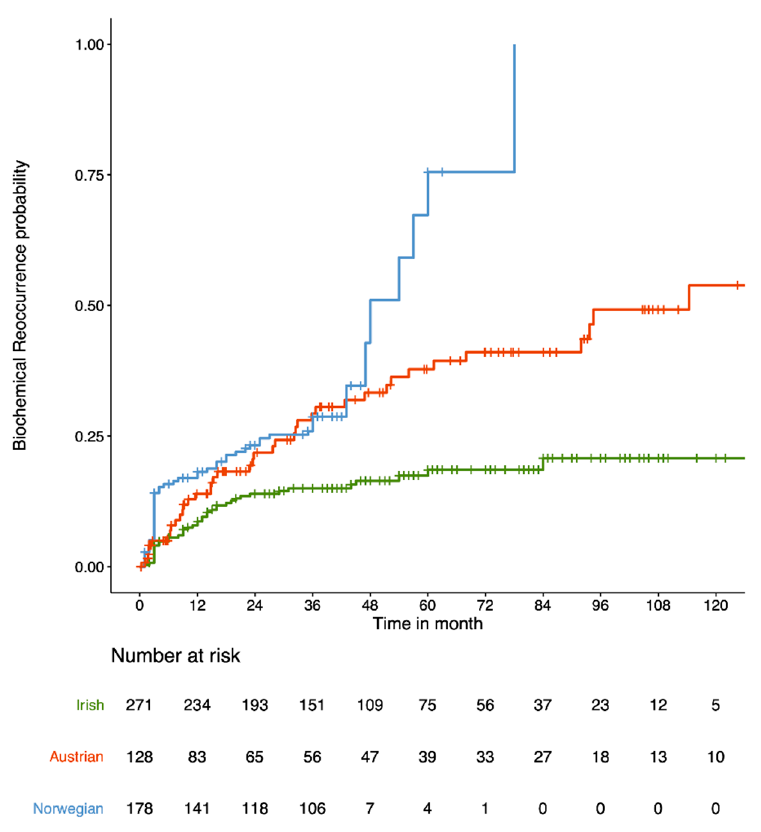
Figure 1. Cumulative probability of time-to-BCR (in months) for the 3 cohorts under investigation: Irish (green), Austrian (red) and Norwegian (blue).